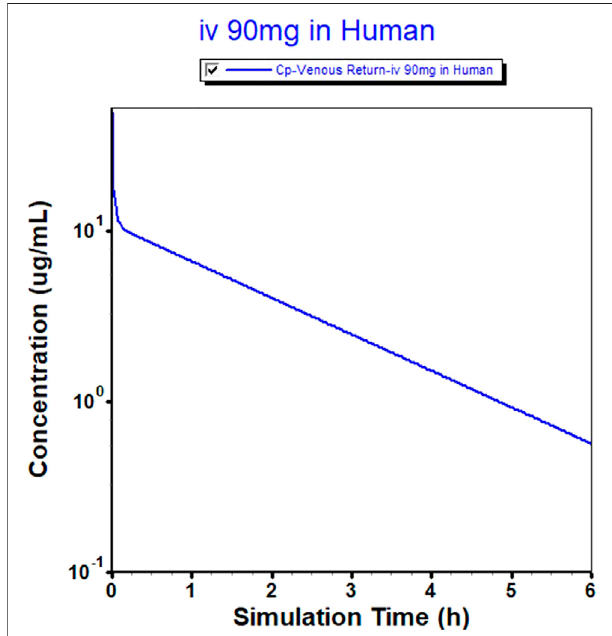
FIGURE 3 | Physiologically based pharmacokinetic (PBPK) model- simulated plasma concentration-time pro fi le in humans after intravenous injection of 90 mg of MK-ASODN